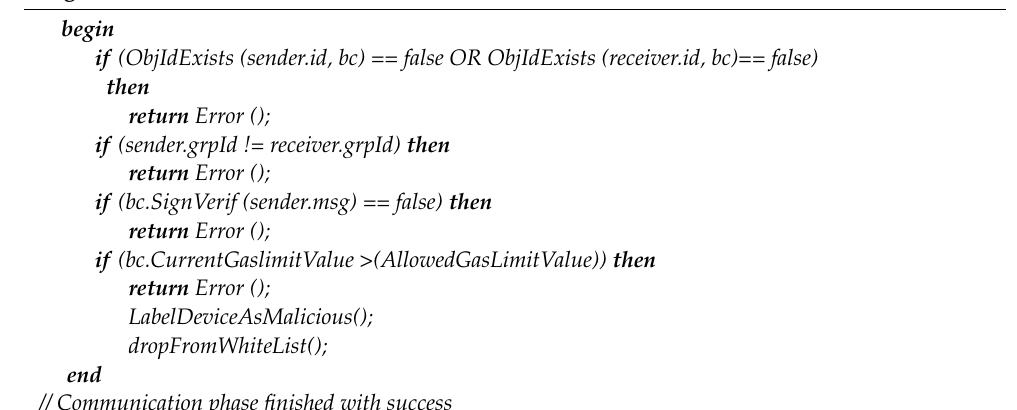
Algorithm 2: Smart Contract Communication